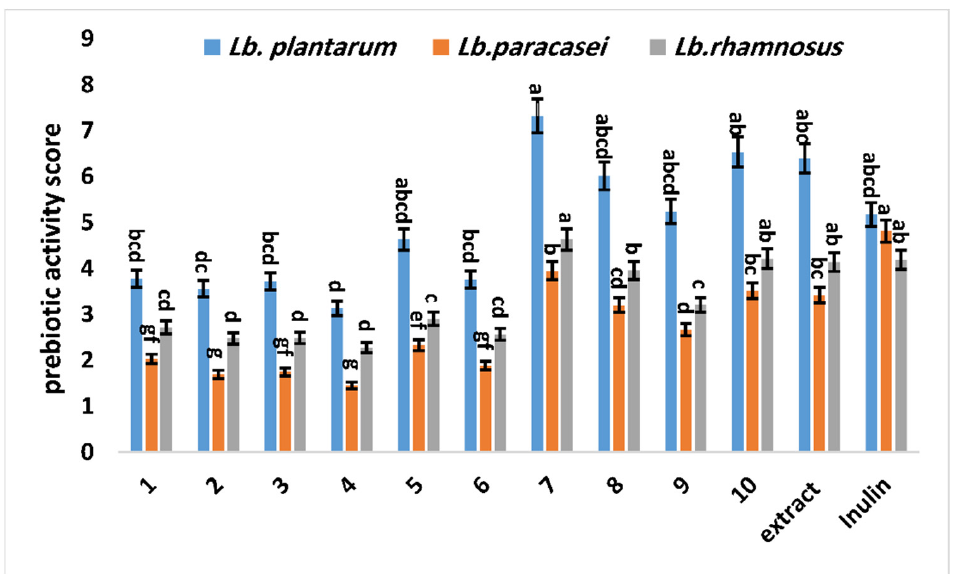
Figure 2. Activity scores (A pre b ) of Lactobacillus spp. strains paired with different isolated compounds ( 1 – 10 ) and methanol extract. Lowercase letters show a significant impact on the prebiotic activity index ( p ˂ 0.05). The standard deviations of the means of the treatments are shown by vertical bars.